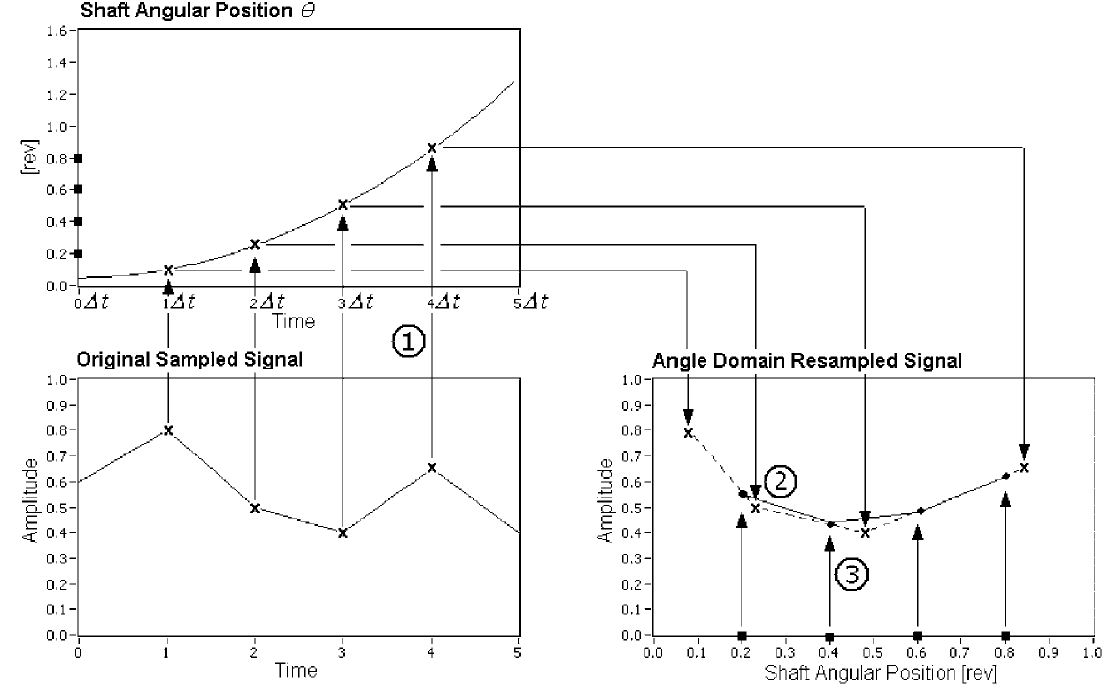
Fig. B2. Proposed method. Key: x = original sampled data, • = resampled data, and (cid:4) = constant angle